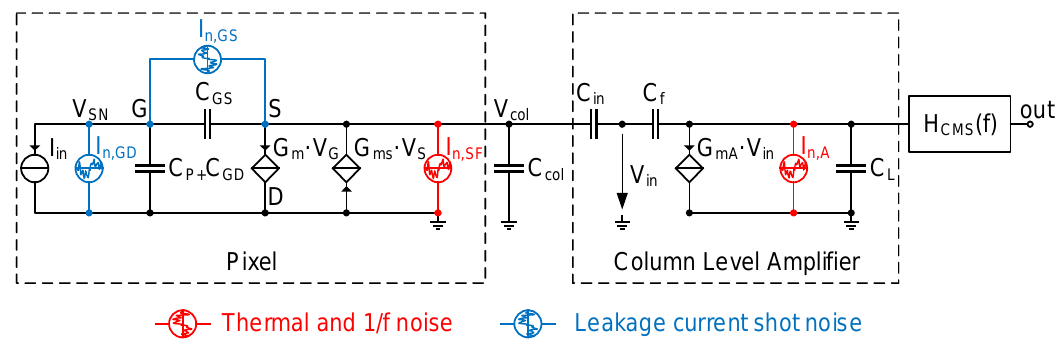
Figure 5. Small-signal analysis of the CIS readout chain depicted in Figure 1 showing the different readout noise sources considered in the